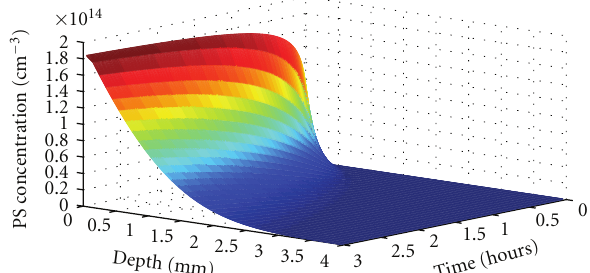
Figure 2: Spatial-temporal distribution of a topical photosensitizer.